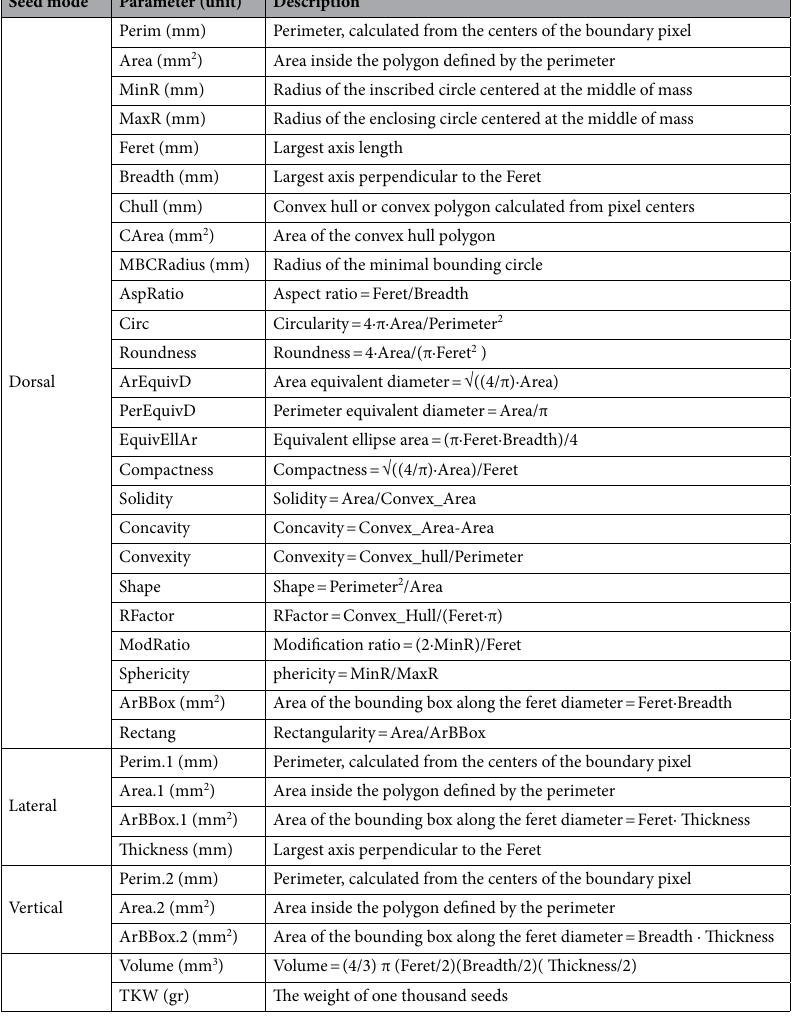
Table 5. Morphometric traits measured on wheat